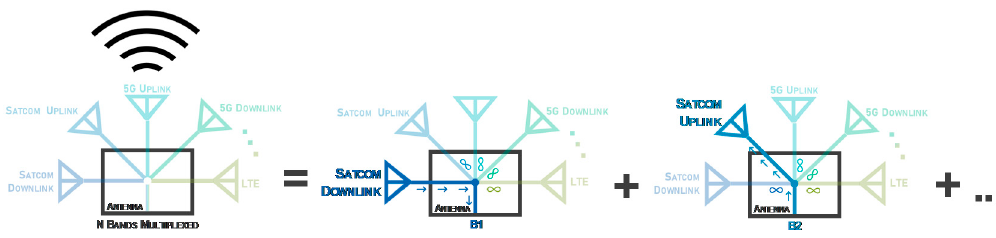
Figure 2. Schematic of the Main Design Concept.